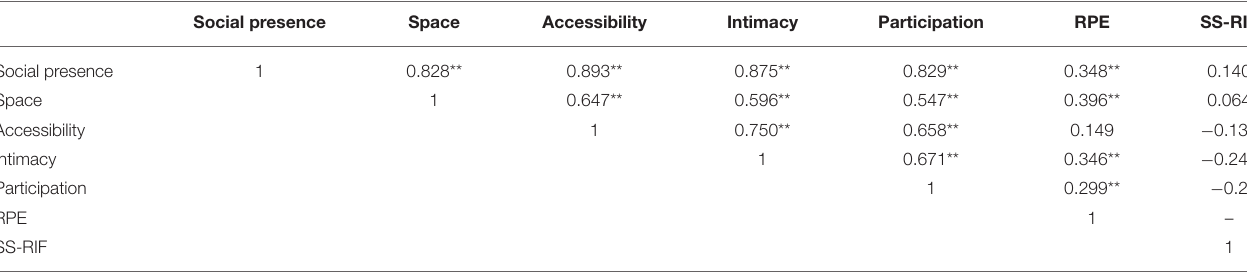
TABLE 3 | Social presence and factors influencing RPE and SS-RIF: a correlation matrix. Social presence Space